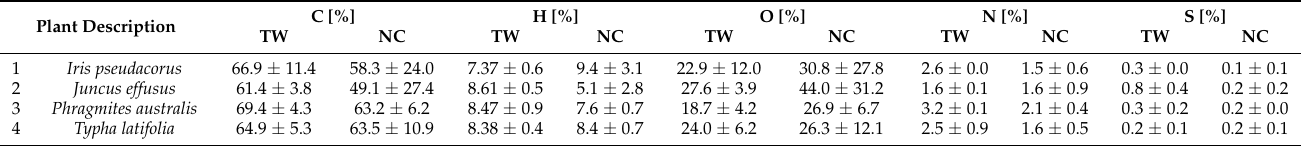
Table 4. C, H, O, N, and S content in the biocrude produced by the selected plants for the different growing environments. Plant Description C [%] H [%] O [%] N [%] S [%] TW NC TW